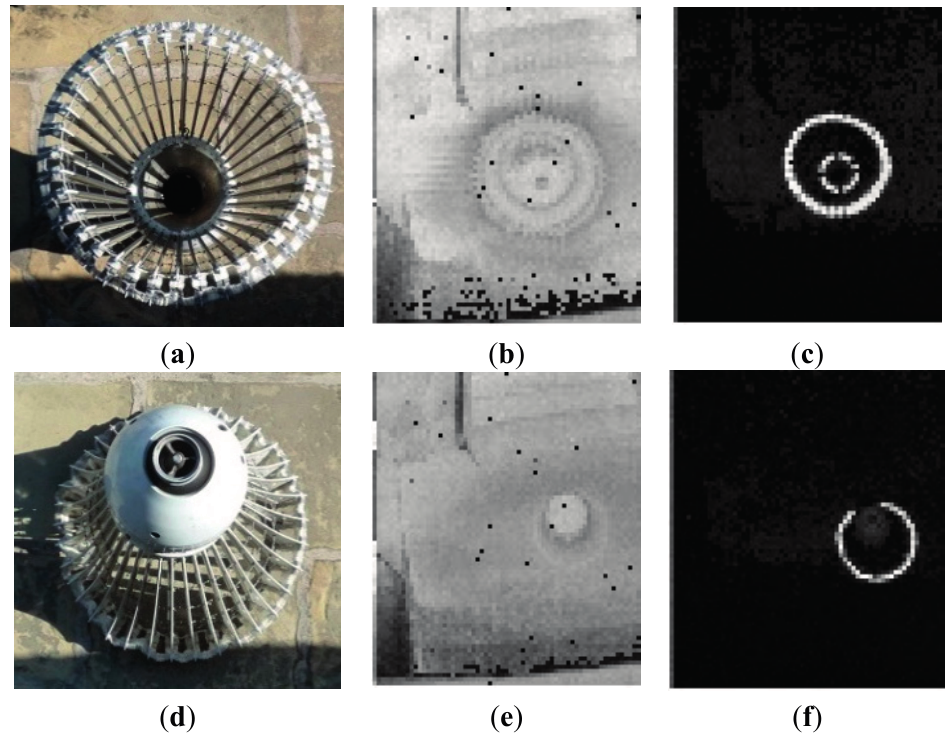
Figure 5. Strong retro-reflective signals from the drogue. ( a – c ) simulate the images perceived by the receiver aircraft; ( d – f ) simulate the images perceived by the